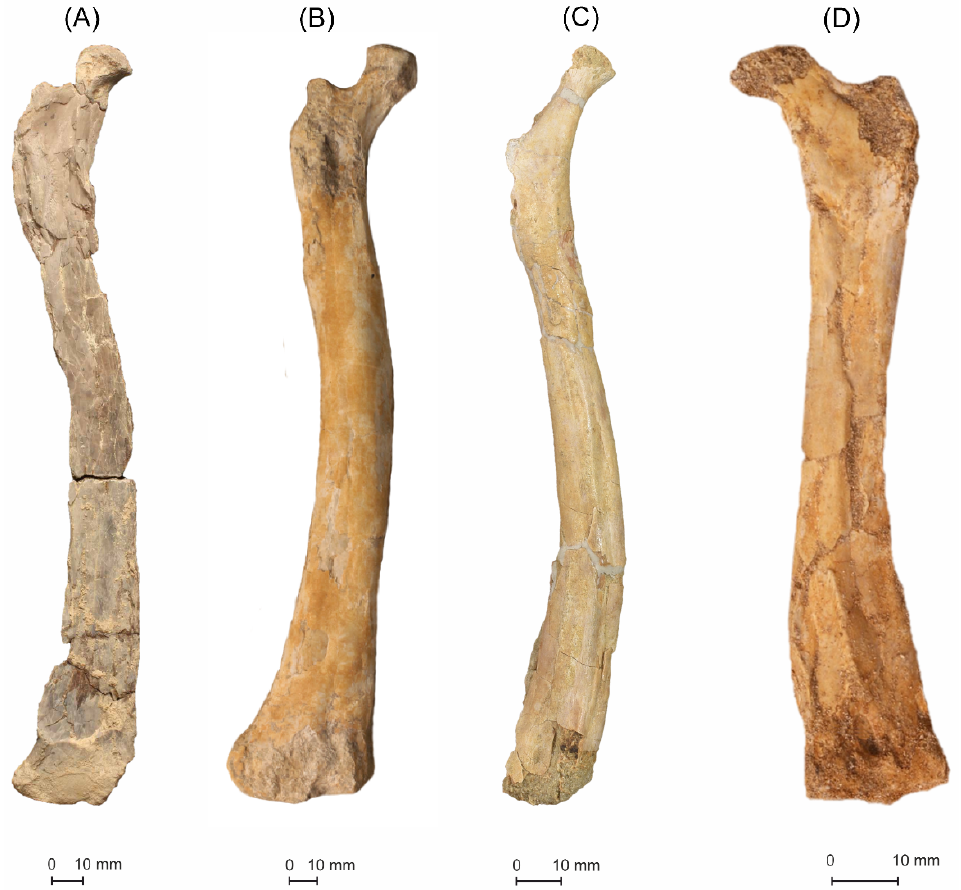
Figure 14. Comparison of pteranodontian femora. ( A ) YPM 2597 Pteranodon sp. (adapted from Longrich et al. 2018 [17]), ( B ) FSAC-OB 201 cf. T . regalis (adapted from Longrich et al. 2018 [17]), ( C ) MGUAN-PA163 Angola specimen, and ( D ) FSAC-OB 5 Alcione elainus (adapted from Longrich et al. 2018 [17]).